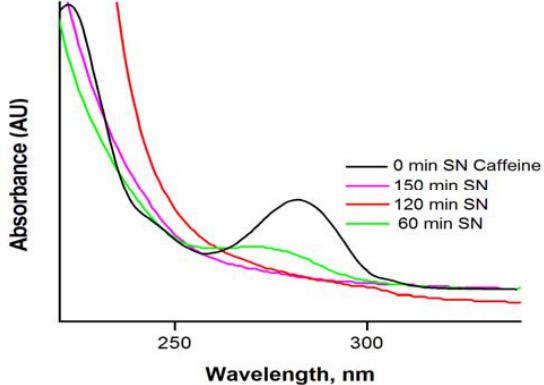
Fig.3 UV- Vis absorption spectra of Caffeine degradation